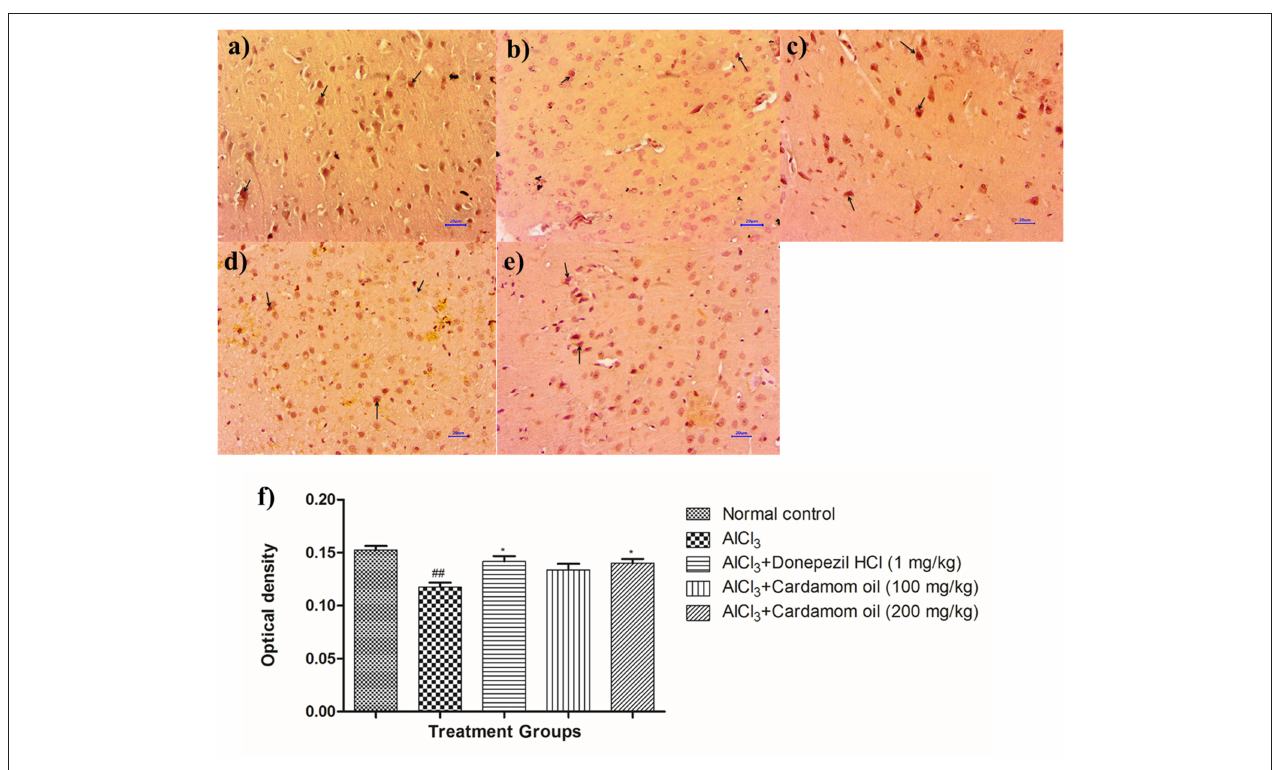
FIGURE 12 | Effect of cardamom oil on BDNF expression in cortex tissue (400X). (a) Normal control: Cortex: showing moderately enhanced expression of BDNF, exhibited by brown coloration at cortical neurons (arrow) {Immunostaining: BDNF, 400X}, (b) AlCl 3 group: Cortex: showing reduced expression of BDNF, exhibited by brown coloration at cortical neurons (arrow) {Immunostaining: BDNF, 400X}, (c) AlCl 3 + Donepezil hydrochloride (1 mg/kg): Cortex: showing moderately enhanced expression of BDNF, exhibited by brown coloration at cortical neurons (arrow) {Immunostaining: BDNF, 400X}, (d) AlCl 3 + Cardamom oil (100 mg/kg): Cortex: showing reduced expression of BDNF, exhibited by brown coloration at cortical neurons (arrow) {Immunostaining: BDNF, 400X}, (e) AlCl 3 + Cardamom oil (200 mg/kg): Cortex: showing mild enhanced expression of BDNF, exhibited by brown coloration at cortical neurons (arrow) {Immunostaining: BDNF, 400X,}, (f) Histogram of IHC. Data are expressed as mean ± SEM ( n = 6), ## p < 0.01 when compared with normal control, * p < 0.05 when compared with disease control group. The magnification was 400X. AlCl 3 , Aluminum chloride; SEM, Standard Error of Mean; BDNF, brain- derived neurotrophic factor; IHC,